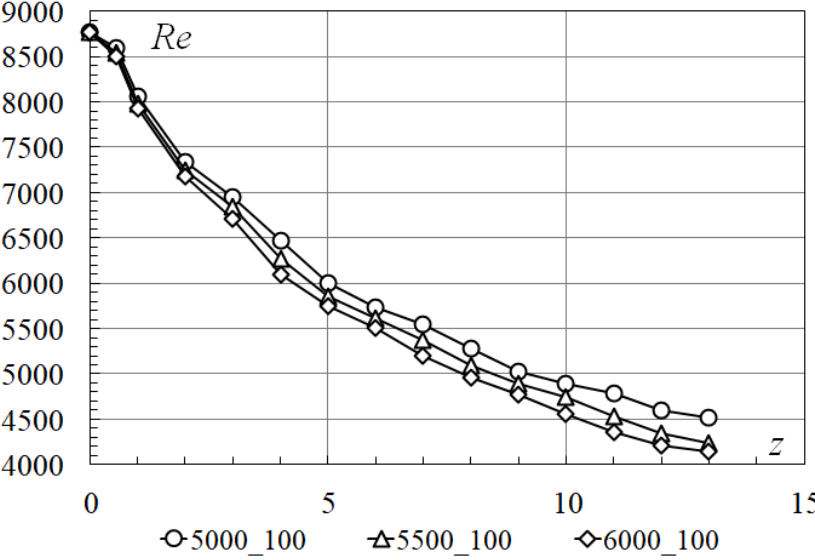
Figure 11. Changing the Reynolds numbers along the length of the duct z [m] q 0 − Varia ; G − Const .